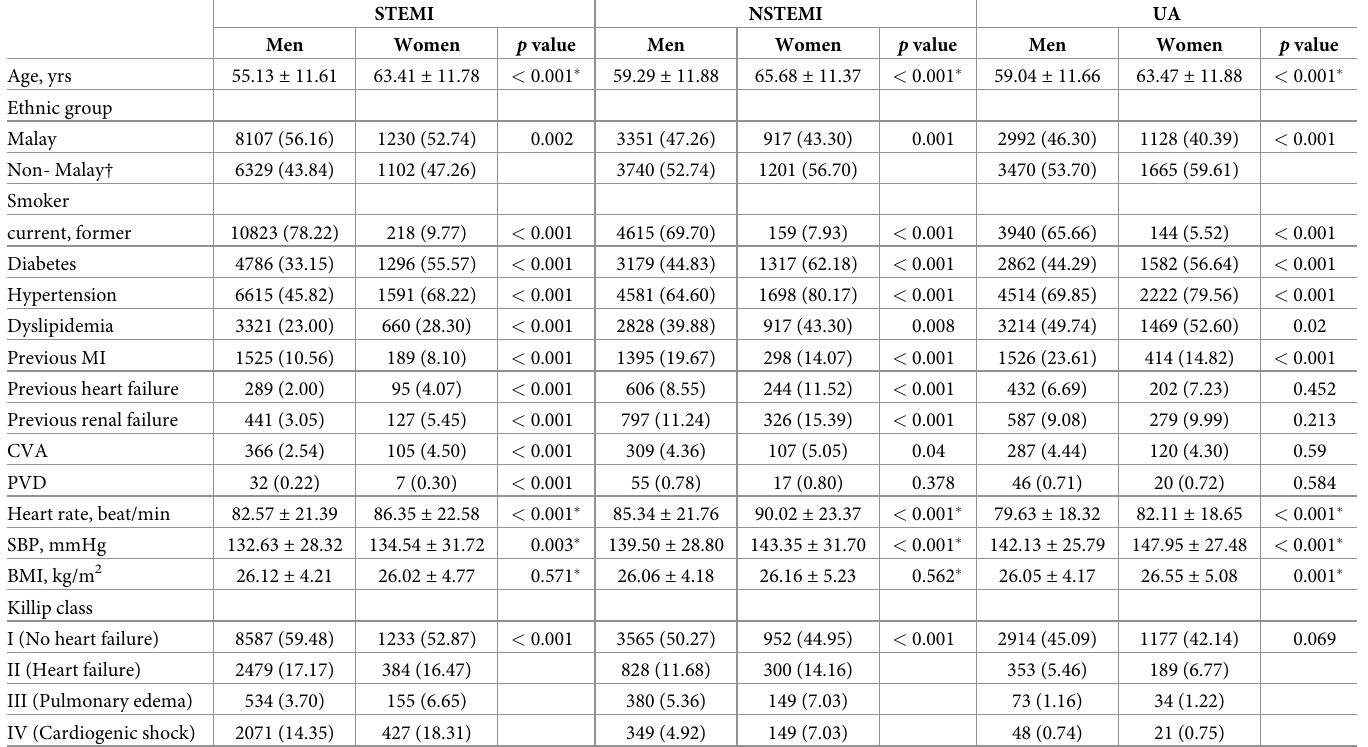
Table 1. Baseline characteristics and risk factors for NCVD-ACS, 2012–2016 (n =